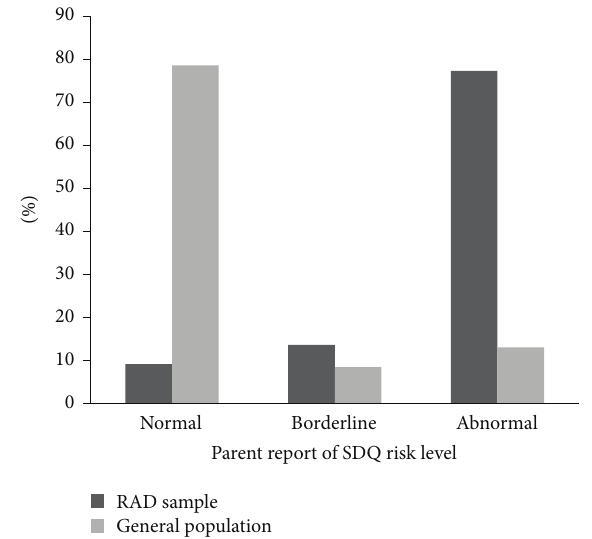
Figure 2: SDQ risk level for problem behaviours in sample of RAD cases compared to the general population.